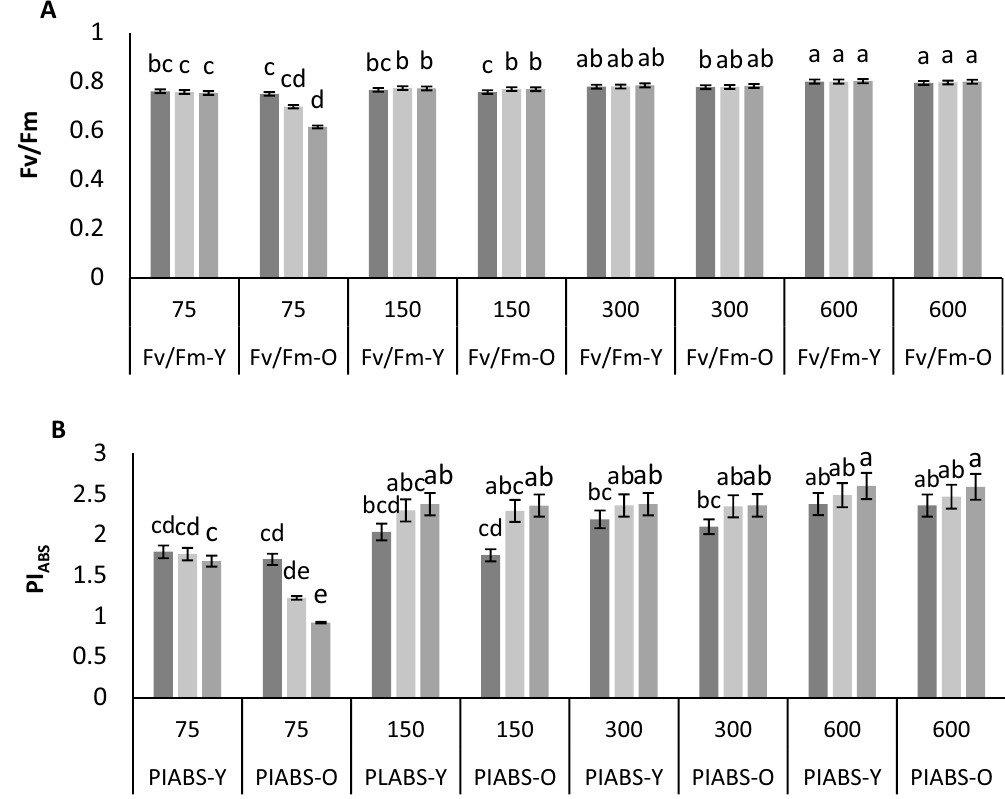
Figure 1. Quantum yield of PSII (F V /F M ) ( A ), and performance index per absorbed light (PI ABS ) ( B ) of young (Y) and old (O) leaves of chrysanthemum plants grown under different light intensits (75, 150, 300, and 600 µmol m −2 s −1 ) and nitrogen (N) concentrations (5, 10, and 15 mM N) at 70 days of cultivation. Vertical bars are means ± SD. Within each graph, interactive effects of light intensity and nitrogen concentration are shown. Different letters (a–d) denote a significant difference between treaments (P <